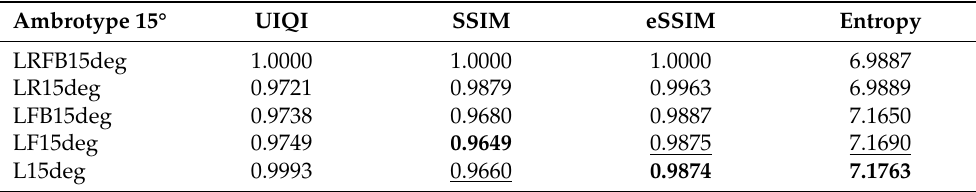
Table 2. Ambrotype 15°. Comparison of images scanned in different scan modes with a reference image scanned in LRFB 15°